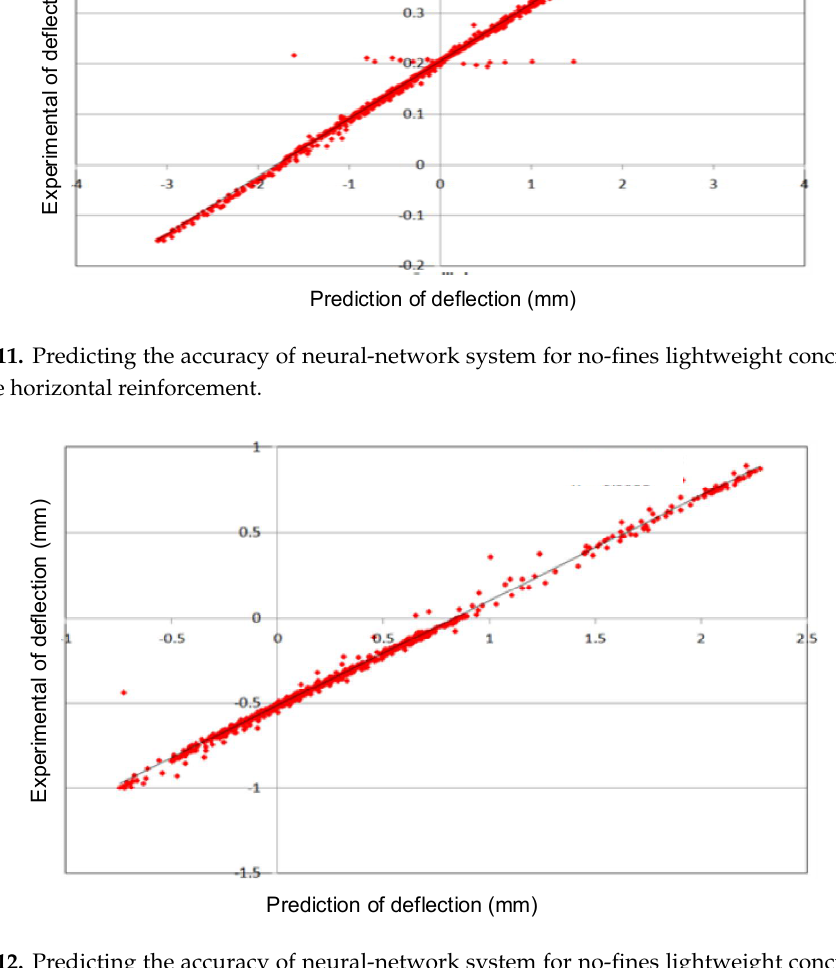
Figure 12. Predicting the accuracy of neural-network system for no-fines lightweight concrete wall without the horizontal reinforcement.